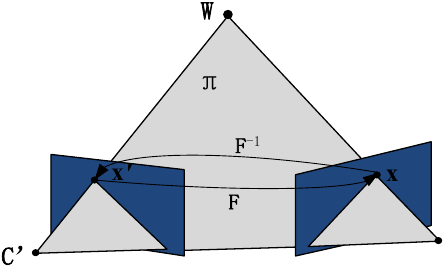
Figure 1. Point-correspondence geometry. FM represents the intrinsic projective geometry between two image planes. It is independent of scene structure and only depends on the cameras’ internal and external parameters of calibrated images. However, the FM between two uncalibrated images can usually be computed from image-point correspondences alone. Specifically, FM is de- fined by the equation